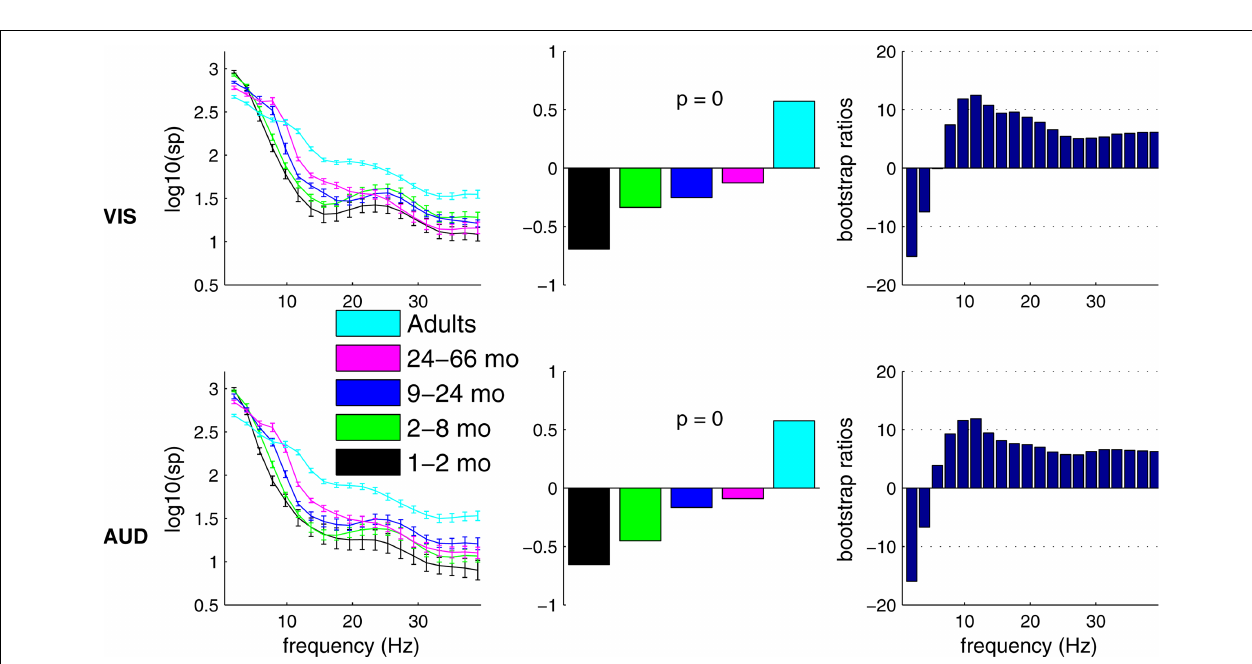
FIGURE 3 | Age-related differences in spectral power distribution estimated separately in VIS and AUD conditions. Left panels show group mean log power with error bars representing group standard errors. Middle panels show PLS contrasts representing age-related change of spectral power distribution. Contrasts for both conditions were signifi cant and stably expressed across most